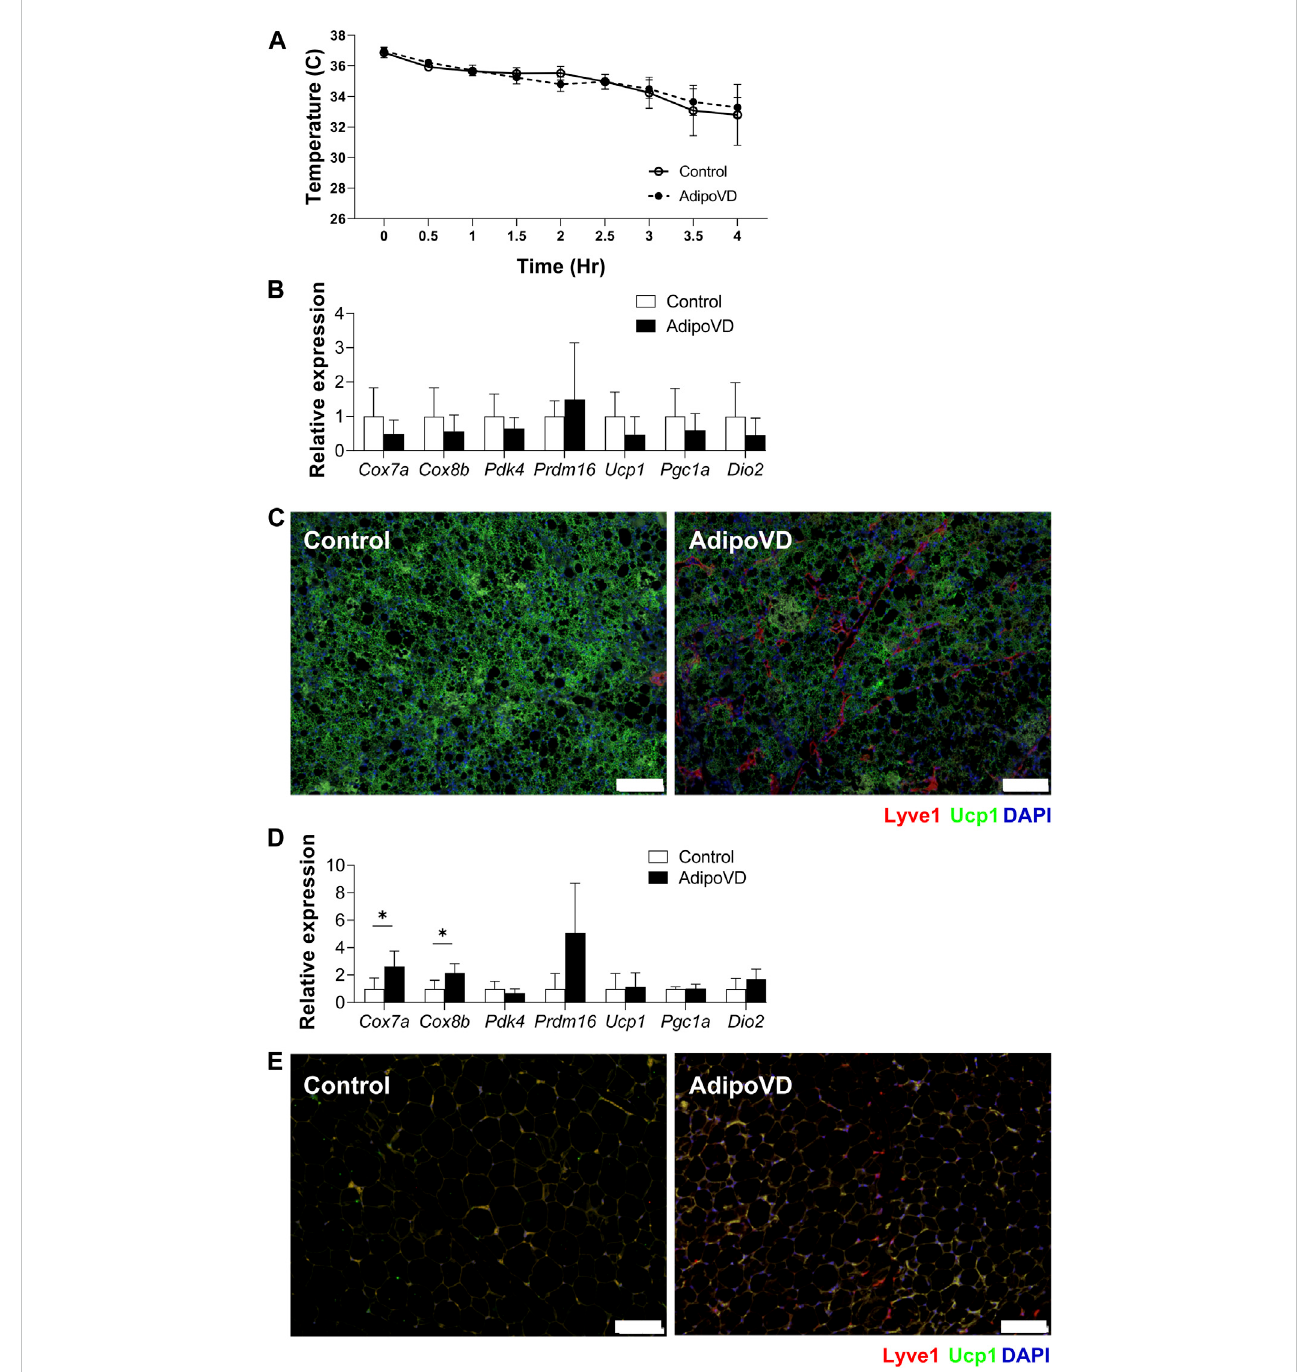
FIGURE 4 Inhibitionofneurotensinactivityamelioratetemperaturedysfunction inAdipoVDmice. (A) BodytemperatureofControlandAdipoVDmiceduringacute under cold exposure at 4 ° C after neurotensin receptor inhibition. (B) Browning and thermogenesis-associated gene expression in AdipoVD BAT relative to Controls under acute cold exposure after neurotensin receptor inhibition. (C) Immuno fl uorescence of UCP-1 (green) and lymphatics (red; LYVE-1) from BAT depot of Control and AdipoVD following cold exposure. (D) Browning and thermogenesis-associated gene expression in AdipoVD SQAT relative to Controls following cold exposure and neurotensin receptor inhibition. (E) Immuno fl uorescence of UCP-1 (green) and lymphatics (red; LYVE-1) from SQAT depotofControlandAdipoVDfollowingcoldexposure andneurotensinreceptorinhibition. (A – E) n =10control/ n =7AdipoVD. Blue=DAPI.Bars=100